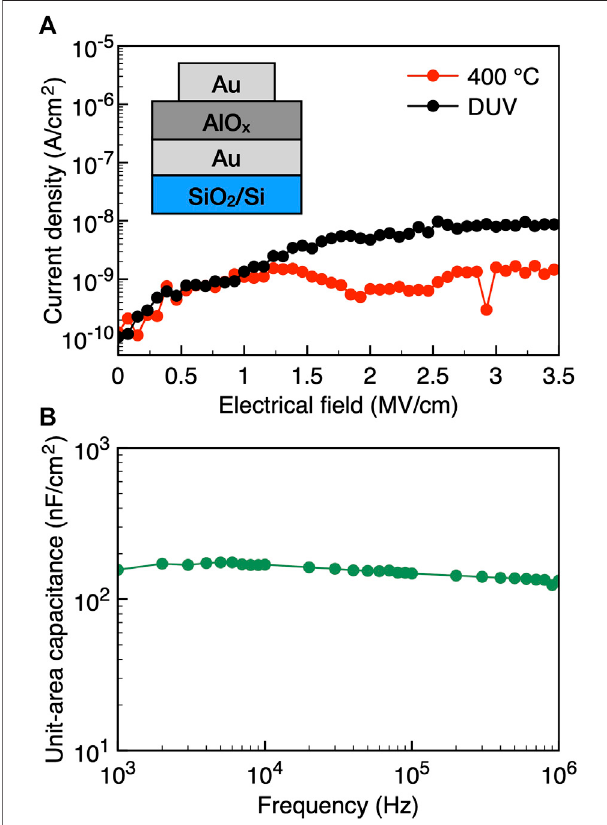
FIGURE3|(A) LeakagecurrentdensityofAlO x dielectricthin fi lmbyhigh temperatureannealingandDUVirradiation,theinsetisaschematicdrawingof the MIM device structure. (B) Unit-area capacitance of AlO x dielectric thin fi lm by DUV irradiation.